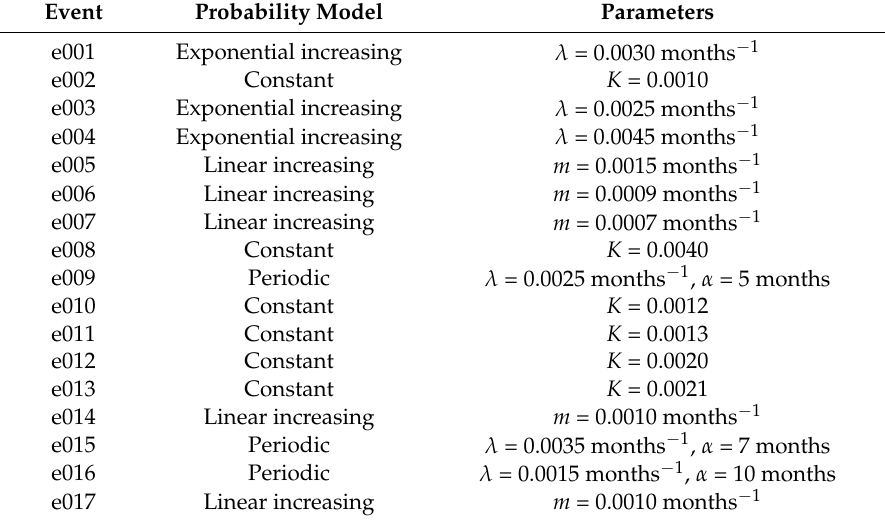
Table 4. Probability distributions for the events considered in Figure 7 and Table